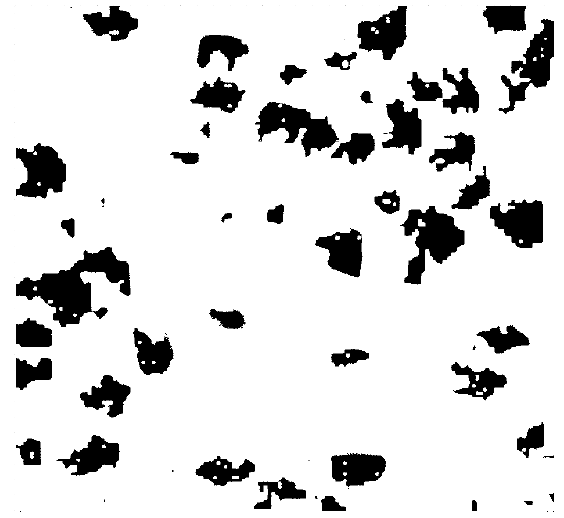
Figure 7. Cellular automata discretization and portrayal of the patch structures in black [54].